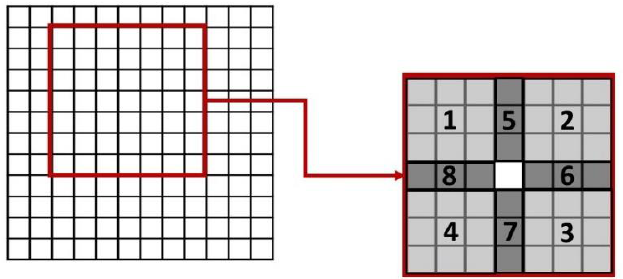
Figure 3. Zoning criteria to define the sub-kernels for Smoothing Moving Polynomial Fitting (SMPF).